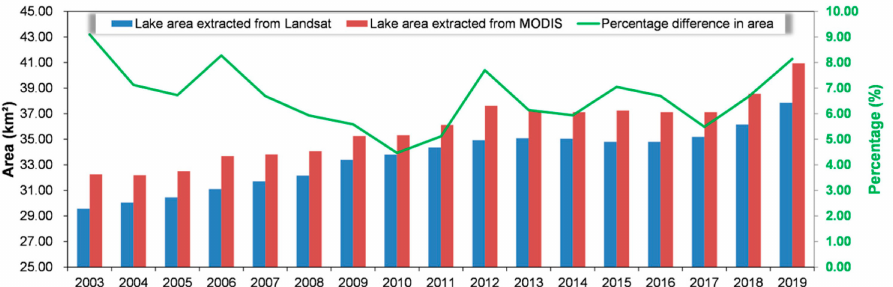
Figure 5. Comparison of lake area extracted from Landsat and MODIS products over the same